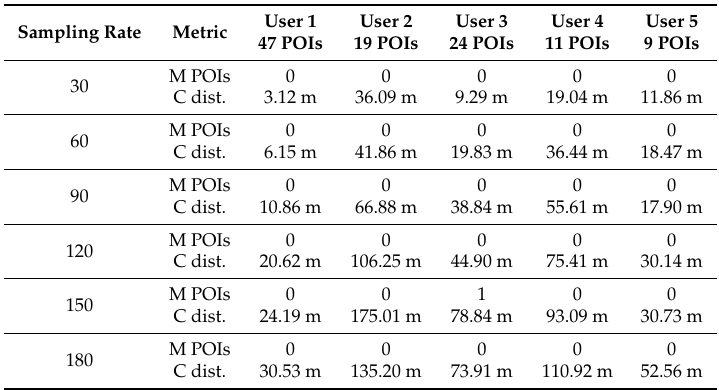
Table 5. Spatial accuracy of mobility events for constructing the cognitive map for different users and varying sampling rates. Variations in GPS accuracy and the lack of GPS signal indoors caused some POIs to be missed (M POIs = Accumulated missed POIs in trajectories for each user; C dist. = Average centroid distance).